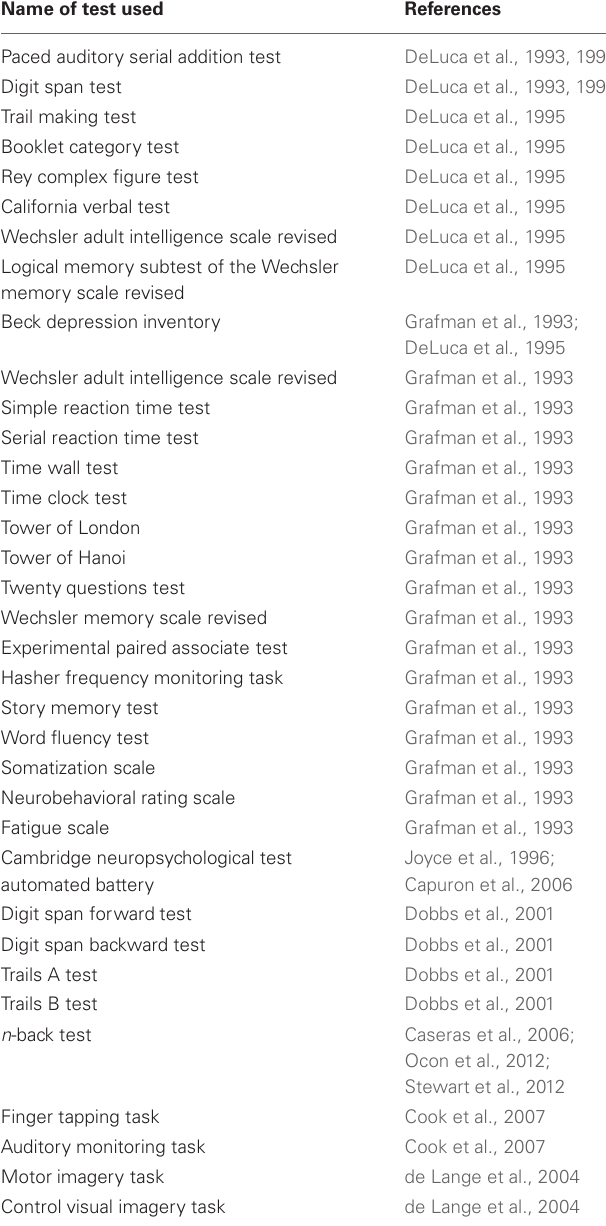
Table 1 | List of cognitive tests used to study Chronic Fatigue Syndrome cognitive